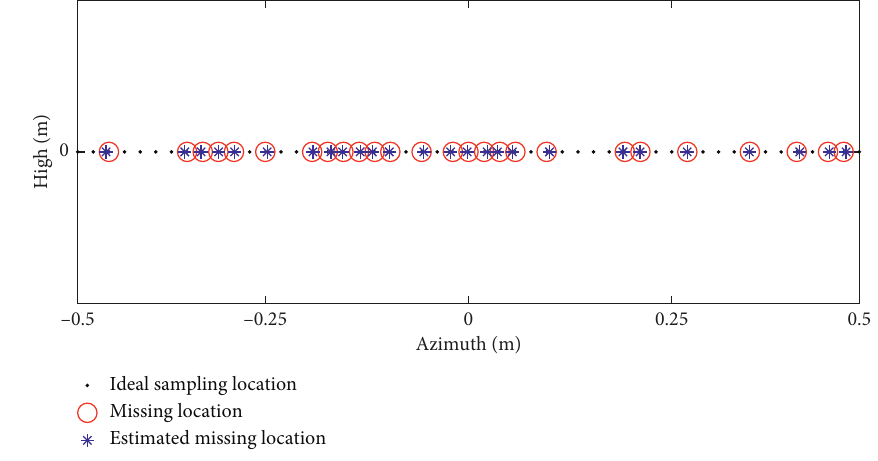
Figure 15: Estimation result of missing data sampling location.